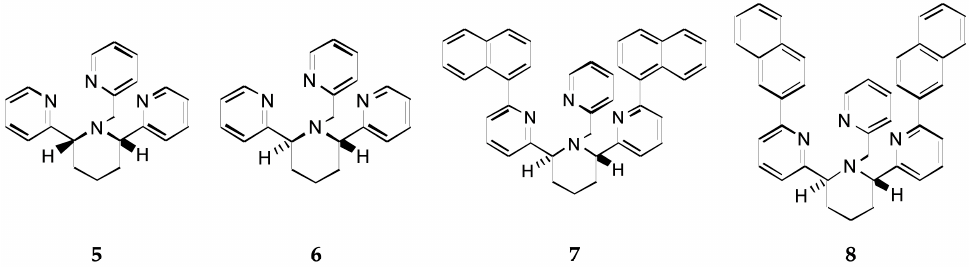
Figure 7. Structures of piperidine derivatives of TPA.